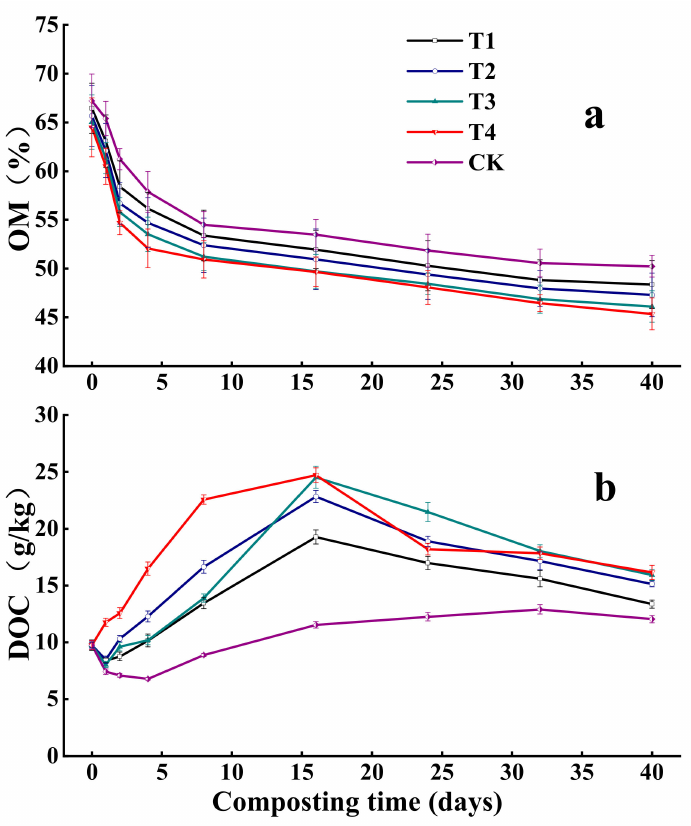
Figure 3. Variations of OM ( a ) and DOC ( b ) of different treatments during the composting